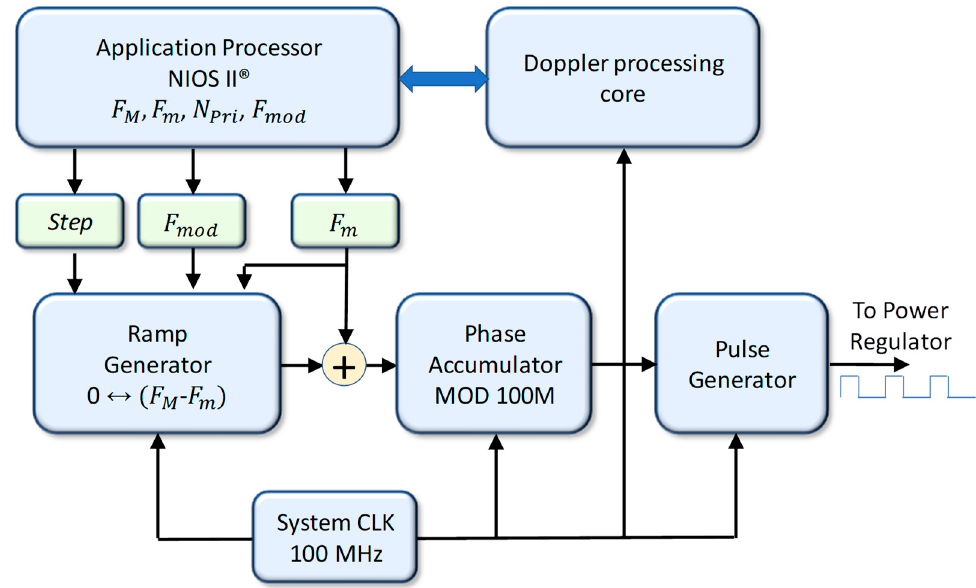
Figure 2. Method implementation in FPGA. The NIOS II soft processor calculates the Step , N Pri , F Mod , F m and F M parameters according to the reported constraints. Step , F Mod and F m are used by the ramp generators to produce a triangular wave of period 1/ F Mod and range 0 ↔ F M − F m . The wave, added to F m , enters an accumulator module 100 M. The phase is used for the synthesis of the synchronization pulse towards the switching regulator. The FPGA works with a 100-MHz clock. Table 1. Selection of the frequency modulation F Mod based on the N Pri value. Table 1 maps the ratios for the generation of the modulation frequency 𝐹 (cid:3014)(cid:3042)(cid:3031) to be used for 𝑇 (cid:3017)(cid:3045)(cid:3036) 1 / N Pri